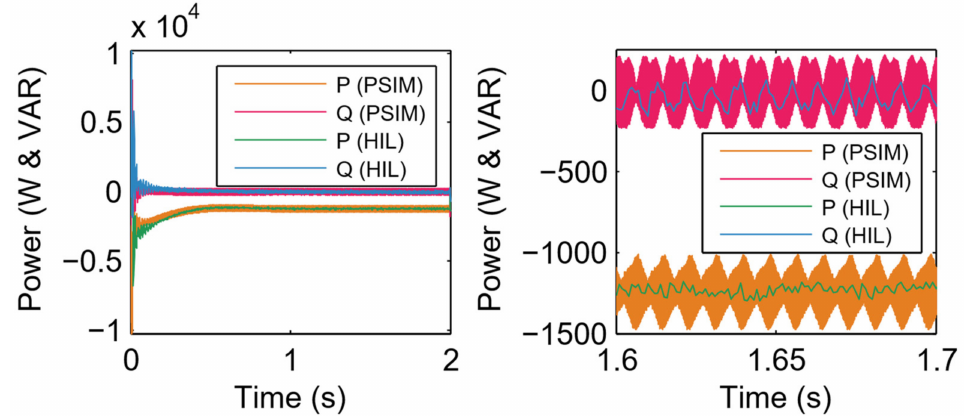
Figure 26. P and Q response under closed loop and rectifier mode conditions.